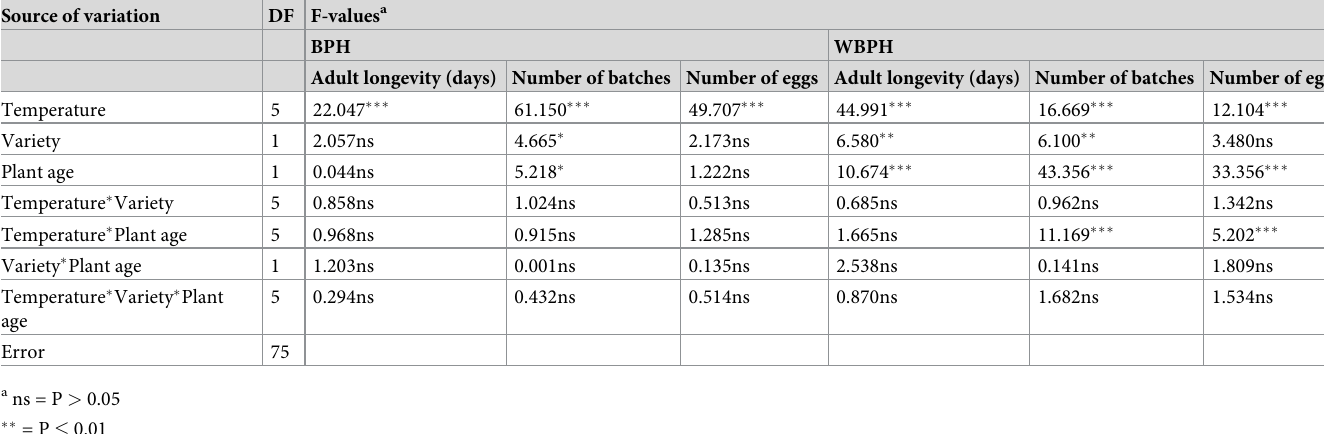
Table 3. Results from univariate GLMs for adult female longevity and oviposition at the end of 20 days (see Fig 3). Source of